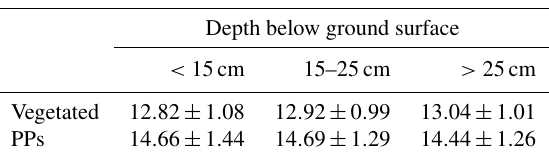
Table A3. Mean soil temperature ( ◦ C) measured at different plot categories and depths together with the mean standard deviation of each